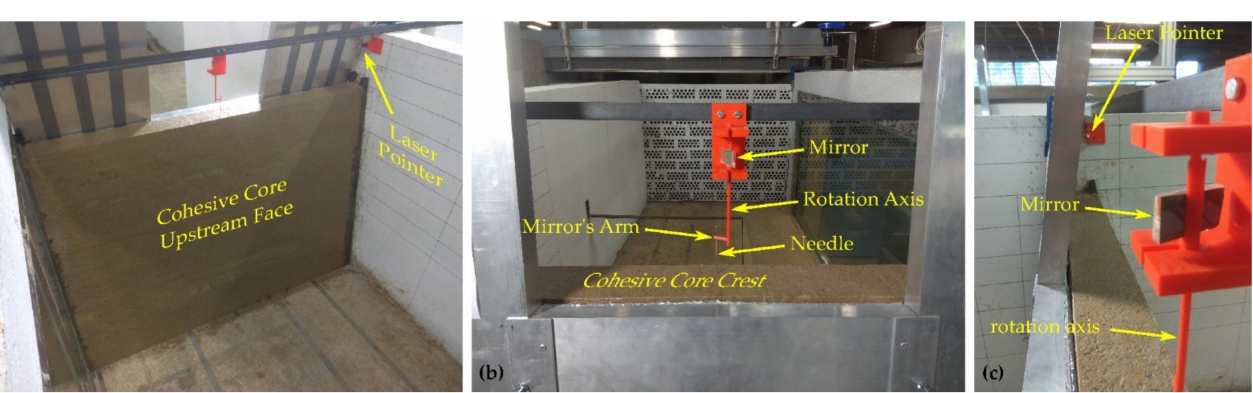
Figure 5. Images of the displacement measuring system: ( a ) View from the upstream side; ( b ) View from the downstream side; ( c ) View along the cohesive core